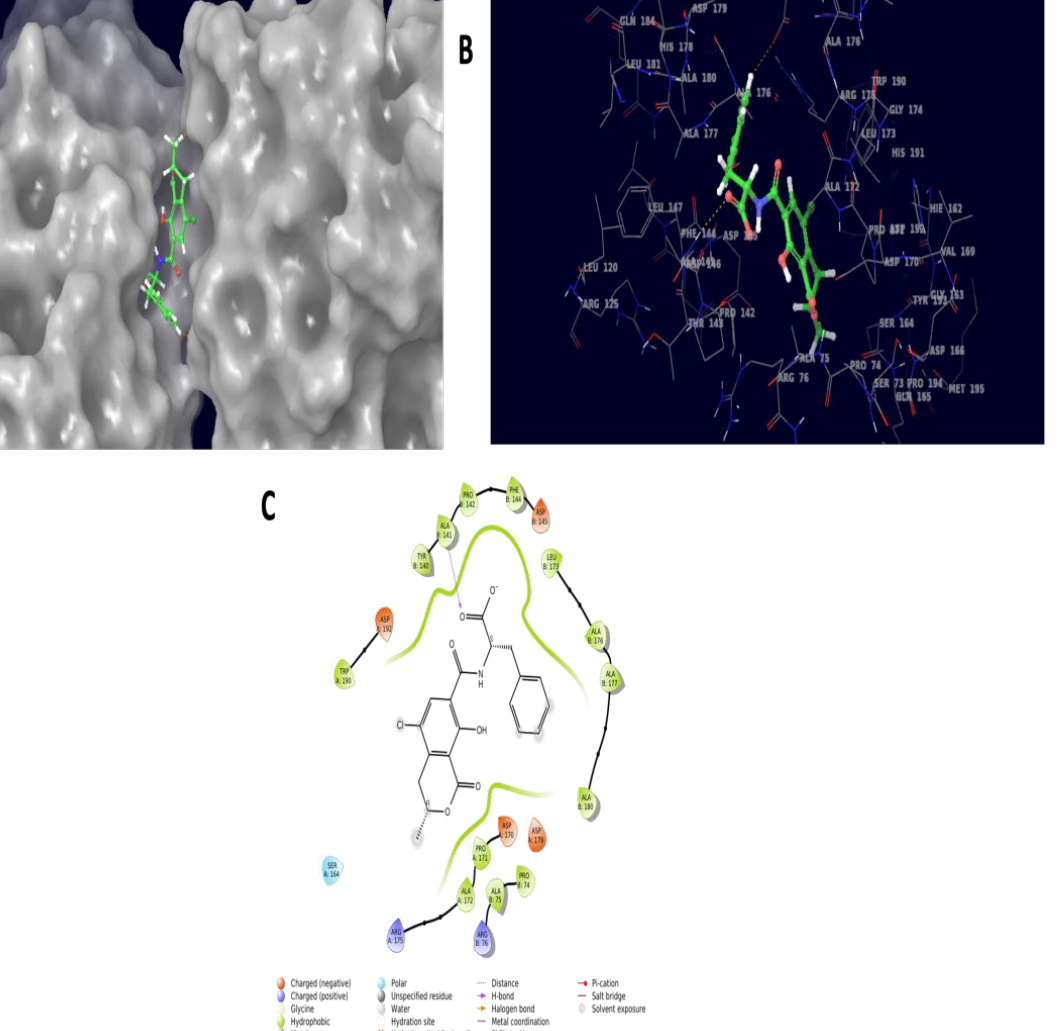
Figure 8. The docked complex molecule of carboxylesterase showing pocket binding sites ( A ), three- dimensional structure of interaction ( B ) and two-dimensional interaction diagram ( C ). This enzyme interacted with the ester molecule of the ochratoxin compound, which could be a possible site for degradation or detoxification